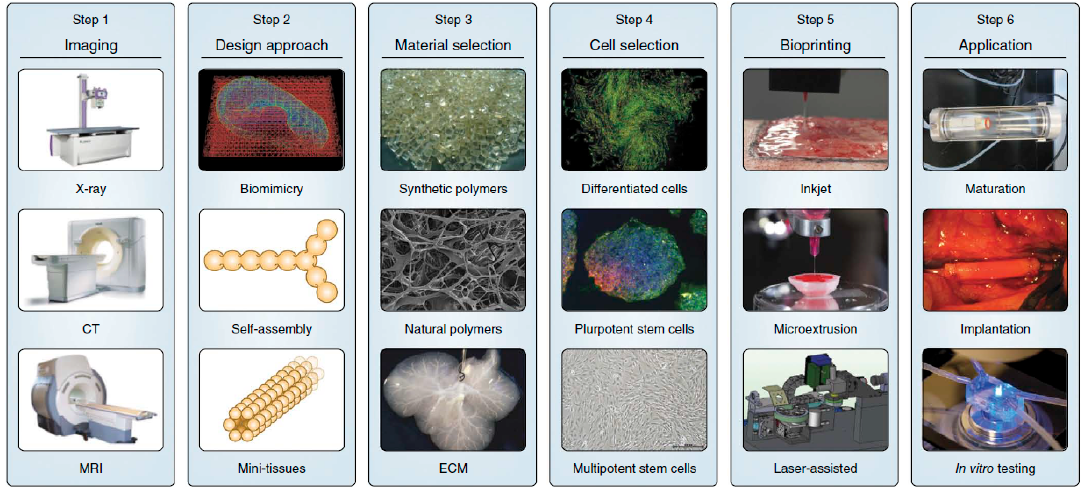
Figure 1. Typical six processes for 3D bioprinting: ( 1 ) imaging the damaged tissue and its environment to guide the design of bioprinted tissues/organs; ( 2 ) design approaches of biomimicry, tissue self-assembly and mini-tissue building blocks are sed singly and in combination; ( 3 ) the choice of materials (synthetic or natural polymers and decellularized ECM) and ( 4 ) cell source (allogeneic or autologous) is essential and specific to the tissue form and function; ( 5 ) bioprinting systems such as inkjet, microextrusion or laser-assisted printers; ( 6 ) tissue maturation in a bioreactor before transplantation or in vitro applications, courtesy of [24].